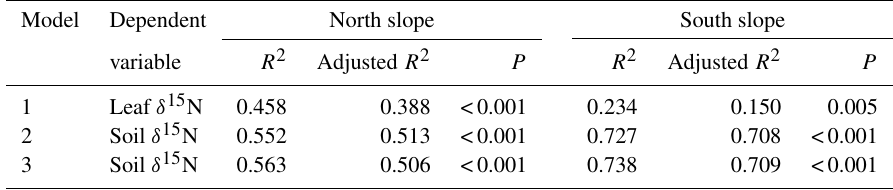
Table 2. Multiple linear regressions of leaf δ 15 N and soil δ 15 N based on ordinary least-square (OLS) estimation.